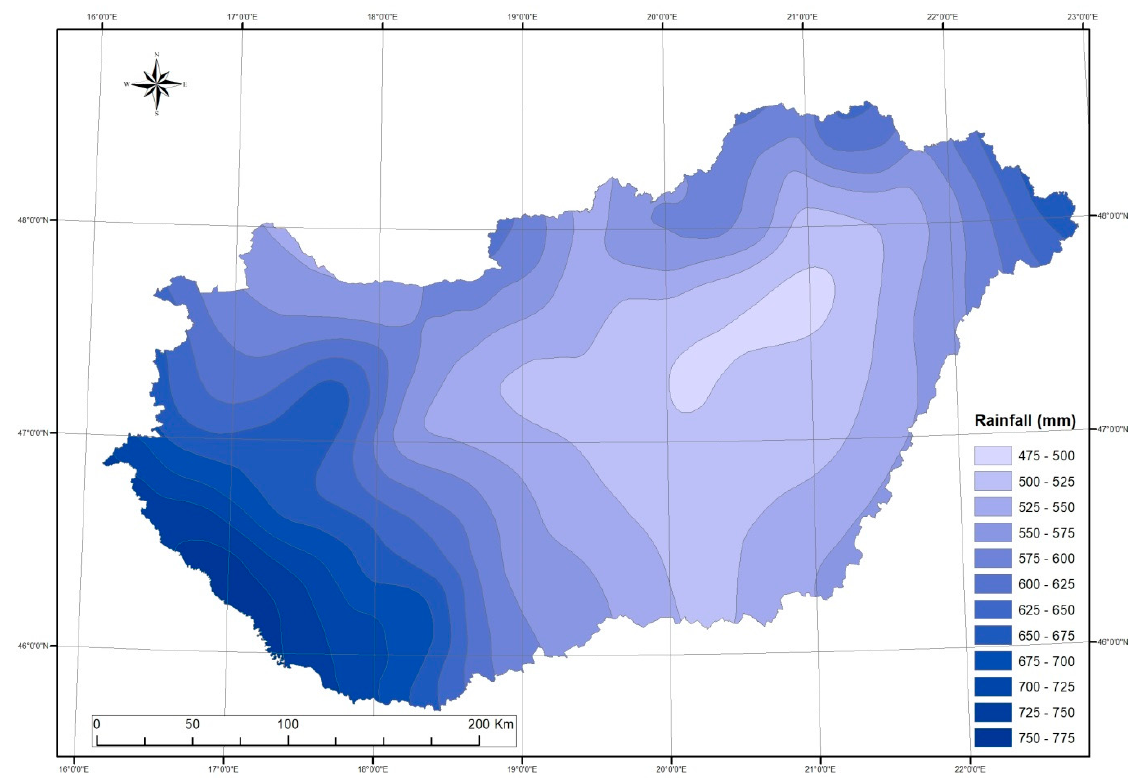
Figure 3. Distribution of thirty-year average precipitation for the period of 1961–1990 based on the CARPATCLIM data- base.